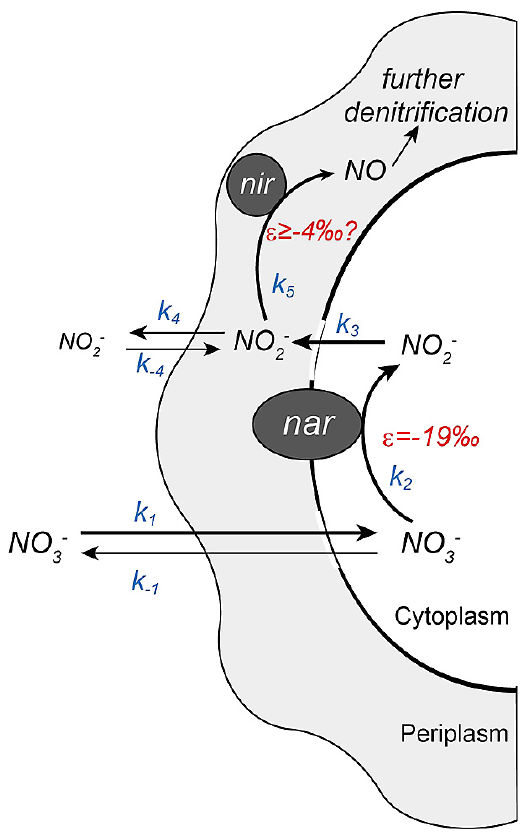
Fig. 6. Illustration of nitrate and nitrite reduction enzymes and their orientation across the bacterial membrane. For the sake of clarity, nitrate ad- and desorption to and from the outer membrane are not shown (see Sect. 4.4, for